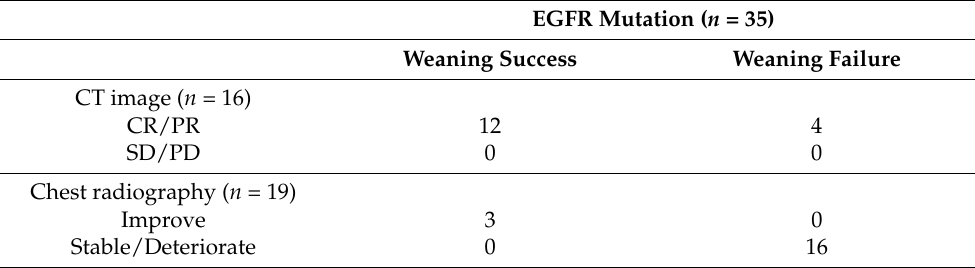
Table 4. EGFR TKI treatment responses and weaning outcomes.